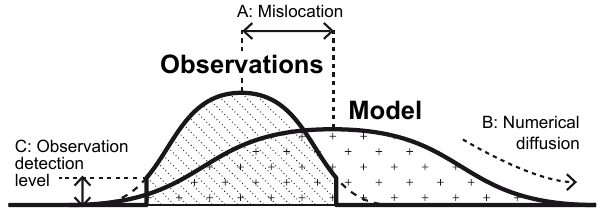
Fig. 3. Schematic cross-section of observed and modelled volcanic